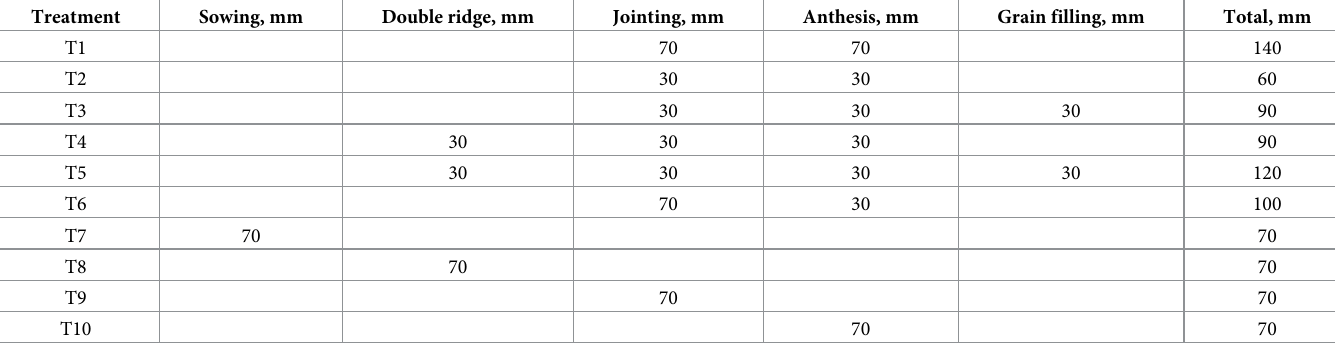
Table 3. Irrigation schedules simulated with the CERES-Wheat model. Treatment Sowing,